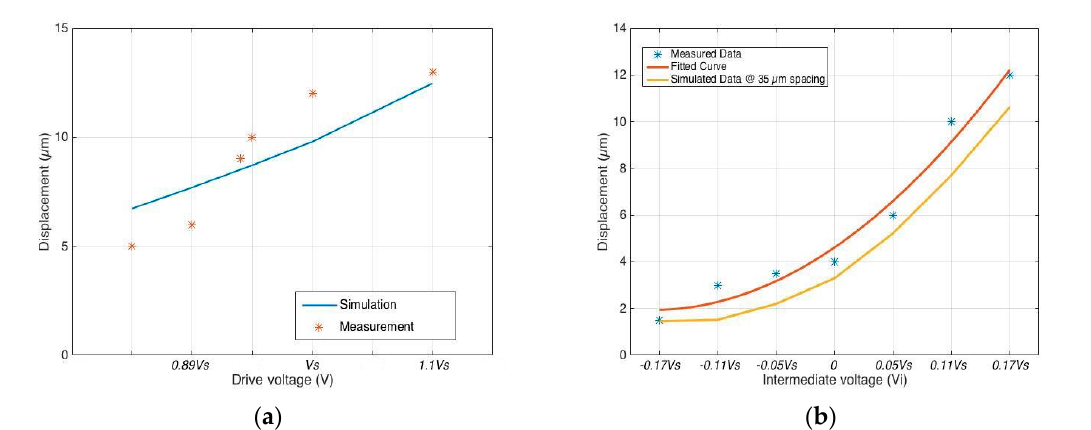
Figure 4. ( a ) Displacement in the conventional drive mode. ( b ) Displacement in the tri-electrode mode V i = ± 0.17 V S